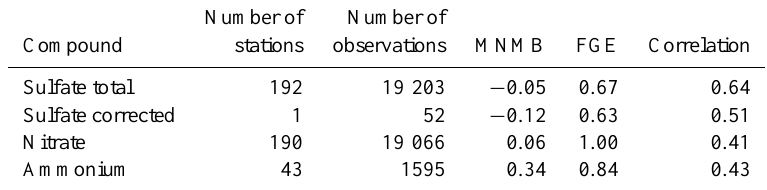
Table 10. Secondary inorganic aerosol compound statistics of the RACMSIA simulation against weekly HTAP observations. Number